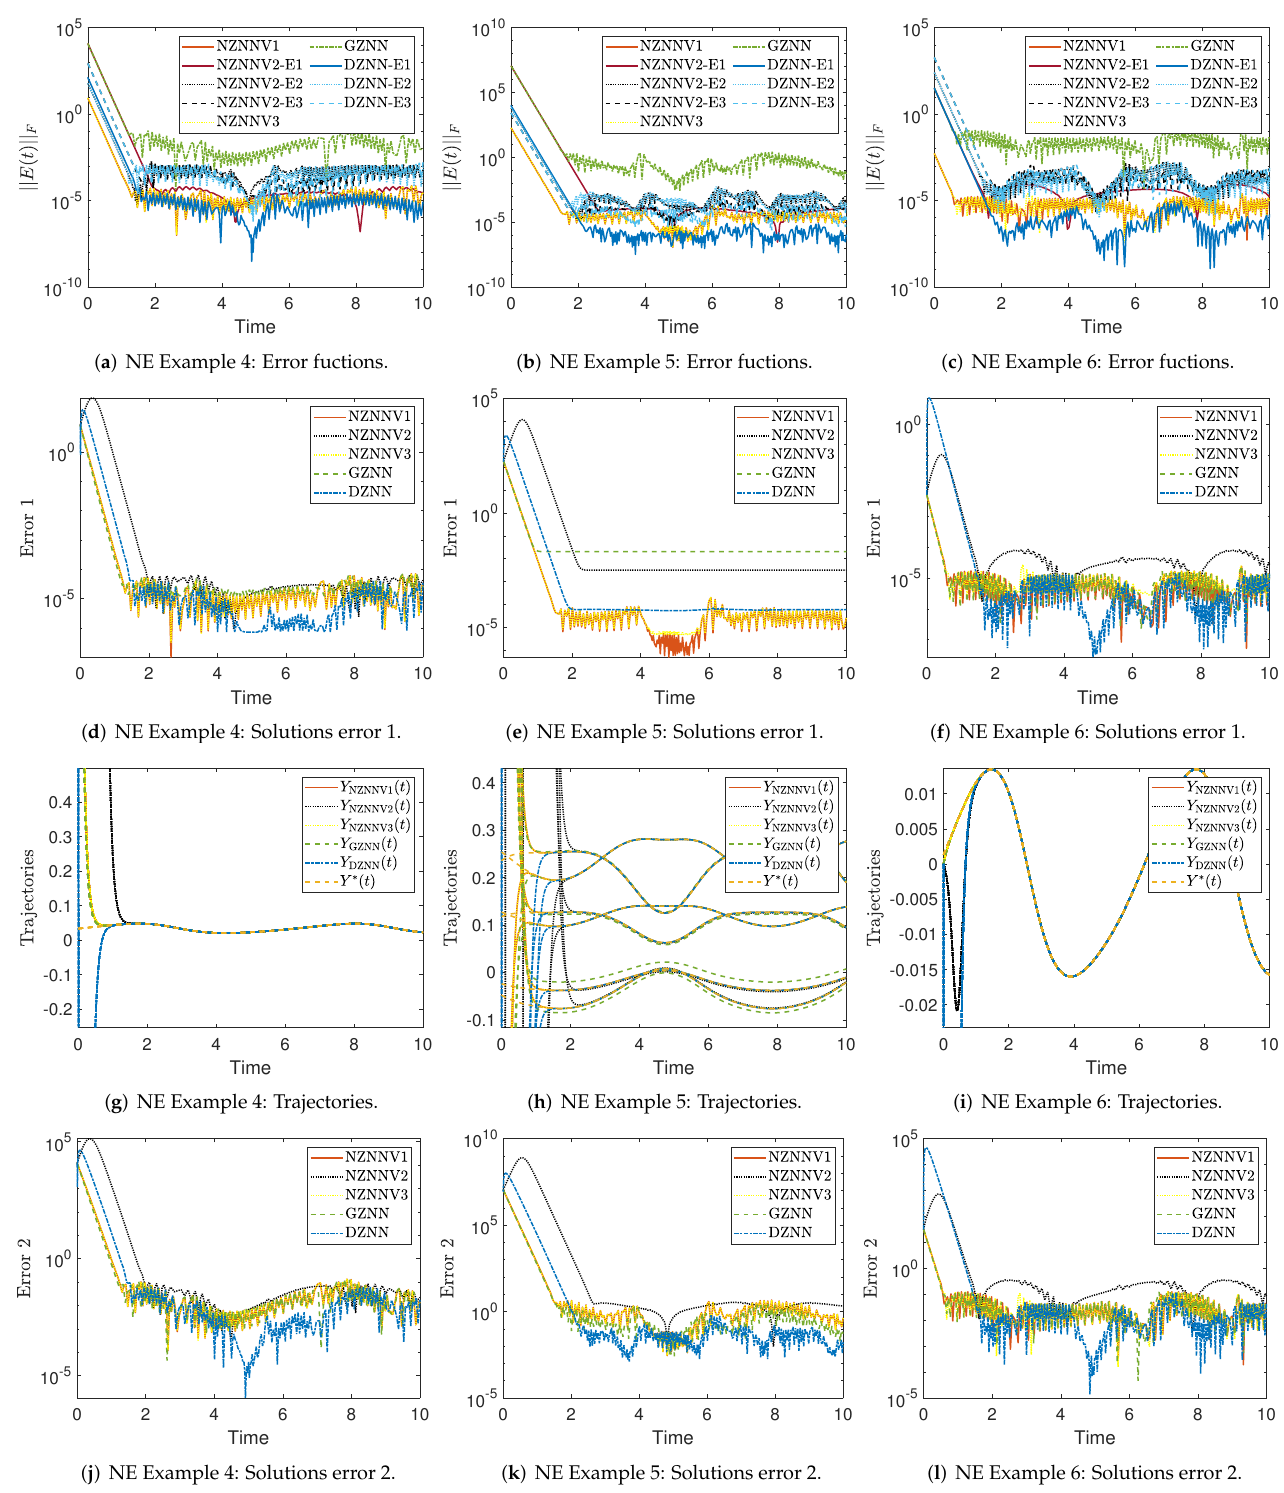
Figure 3. Errors and trajectories in NE Example 4, Example 5 and Example 6 under IC1.